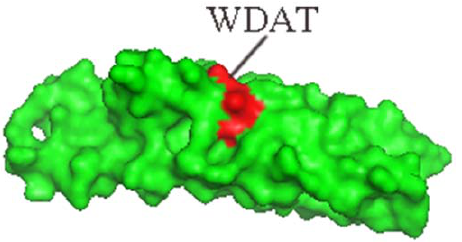
Figure 2. Structure modeling figure of CE protein and WDAT amino acids. The structure modeling figure of CE protein was analyzed with PyMOL software (www.pymol.org), and the W 163 D 164 A 165 T 166 amino acids (red part) was located on the surface of the space structure of CE.